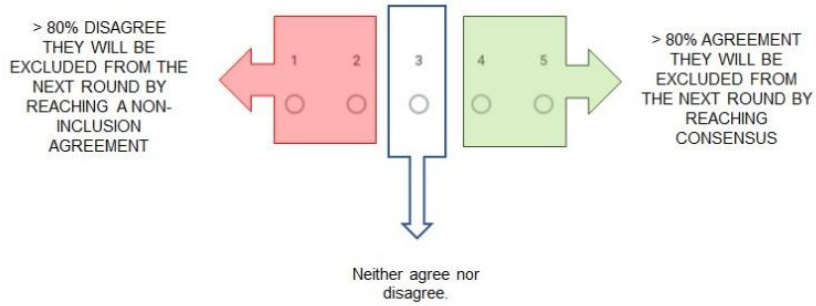
Figure 2. Diagram of the Delphi